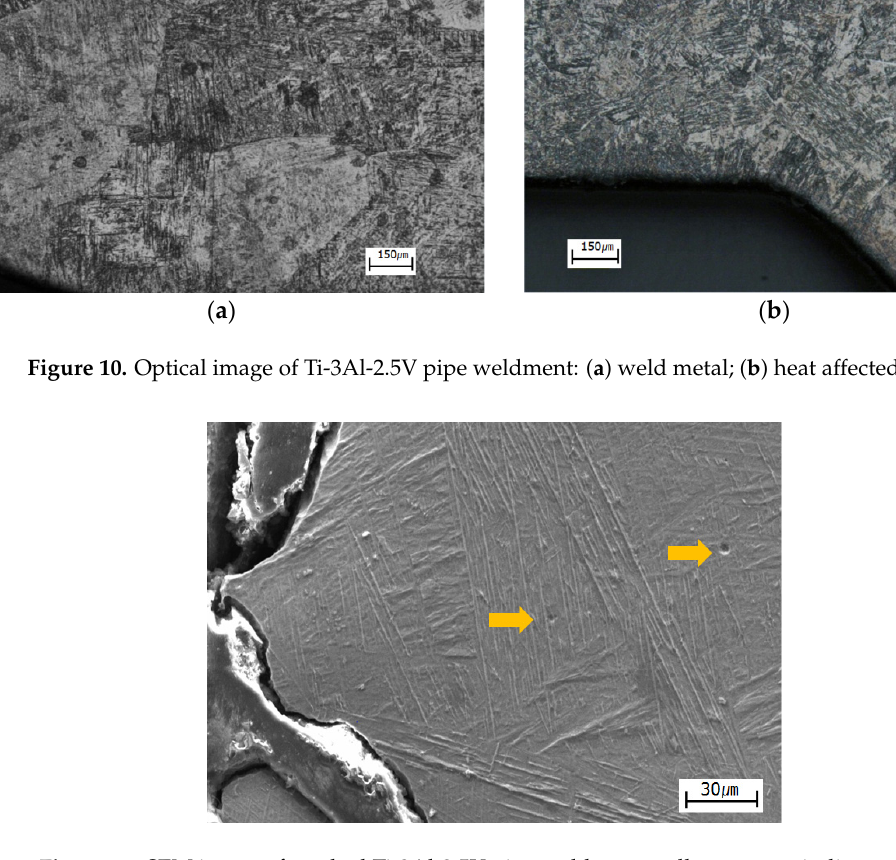
Figure 12. SEM image of fracture surface. Figure 13. Energy dispersive spectroscopy (EDS) test results and SEM image of pores. Table 5. Results of EDS test of porosity. Identification